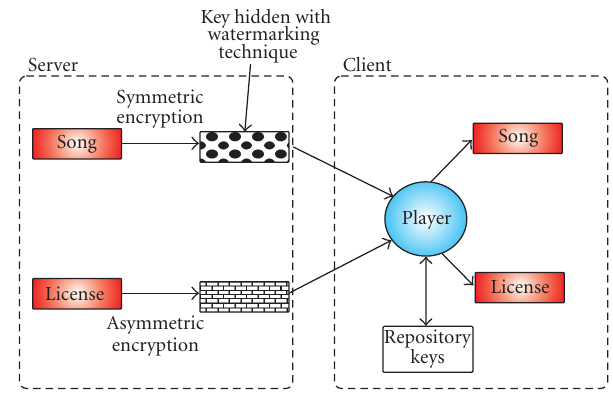
Figure 2: Details of the security mechanism employed in